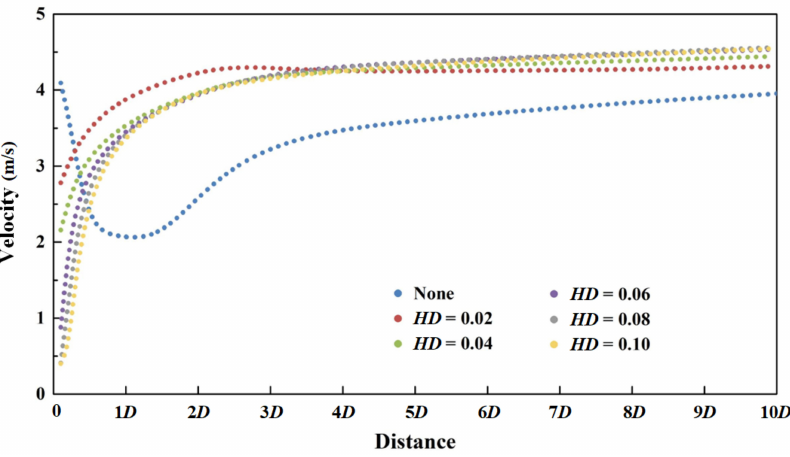
Figure 14. Velocity downstream of 90 ◦ bend pipe with different thick-diameter ratio deflectors. The velocity on horizontal (Line B) and vertical center line (Line C) of the 0.67